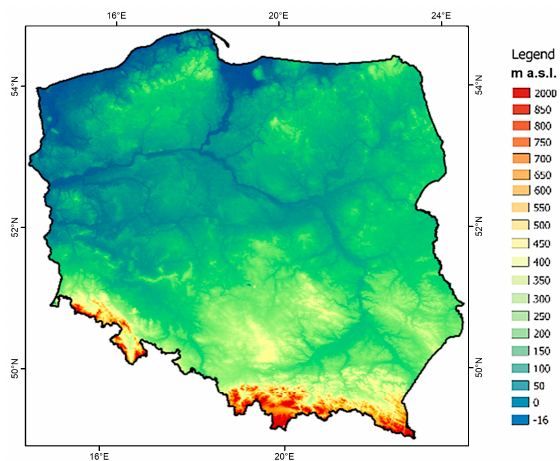
Figure 6. HTC average for Poland.